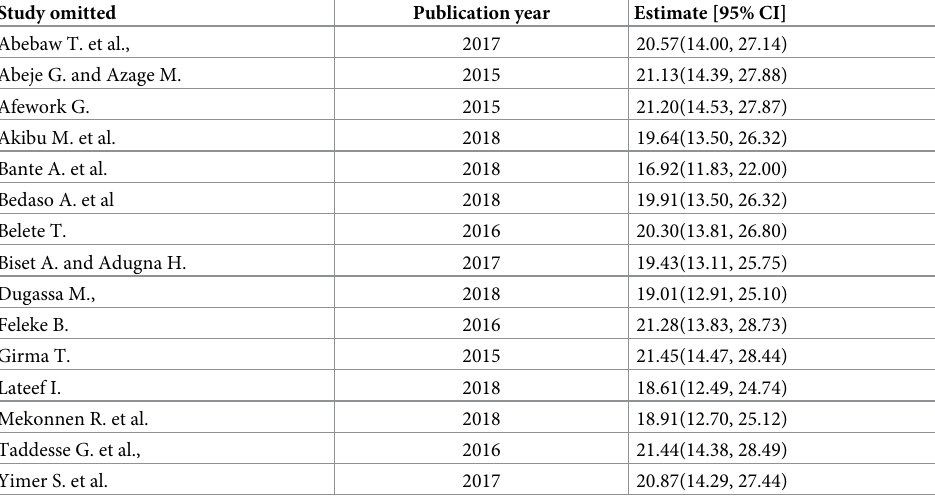
Table 3. Sensitivity analysis of pooled prevalence for each study being removed one at a